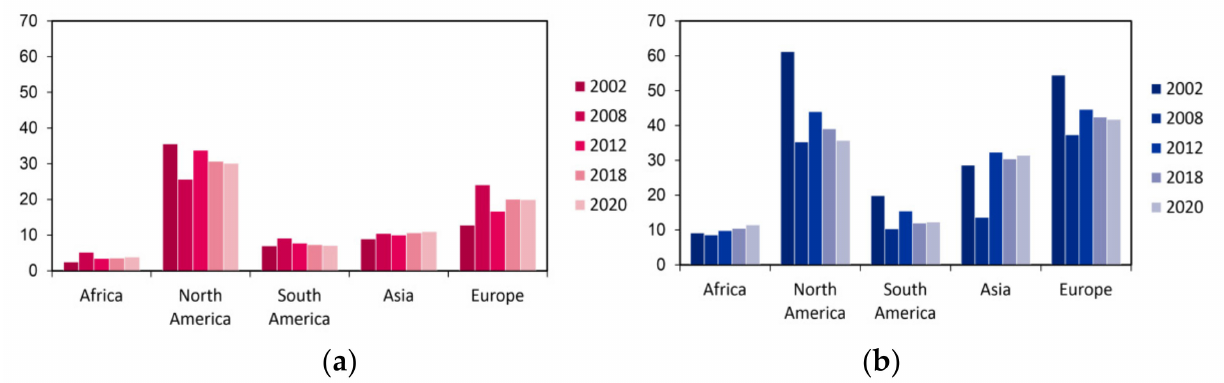
Figure 2. The number of people diagnosed with lung cancer per 100,000 inhabitants. ( a ) Incidence among women concerning world regions in 2002–2020; ( b ) Incidence among men concerning world regions in 2002–2020